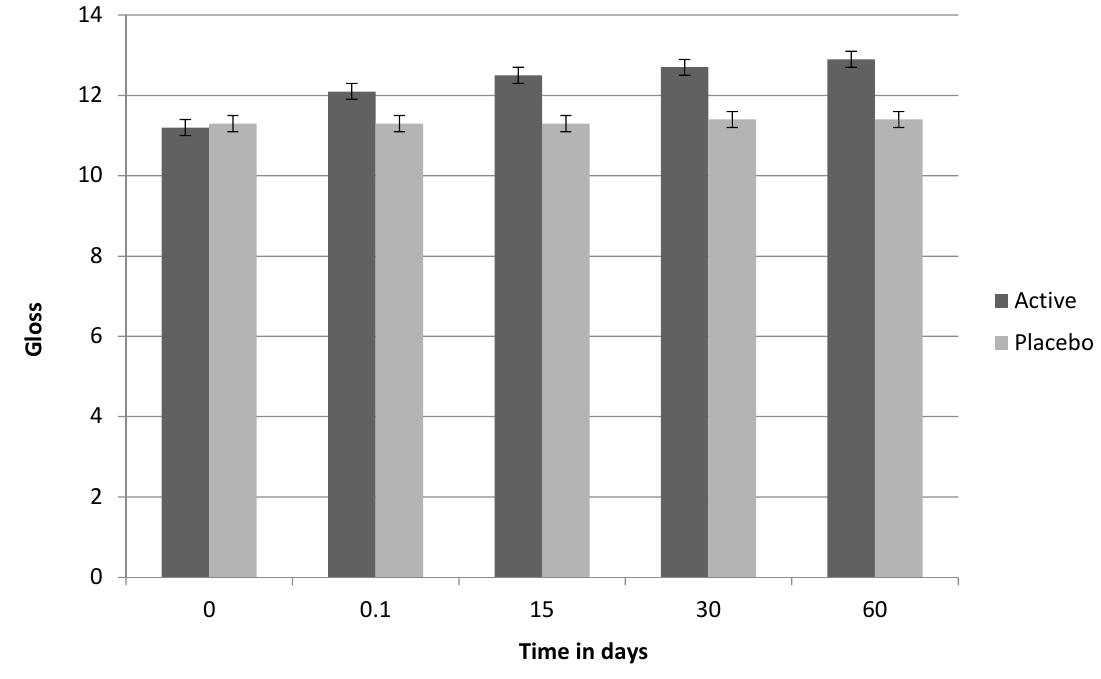
Figure 4. Clinical test on Fucus vesiculosus extract: wrinkle depth over